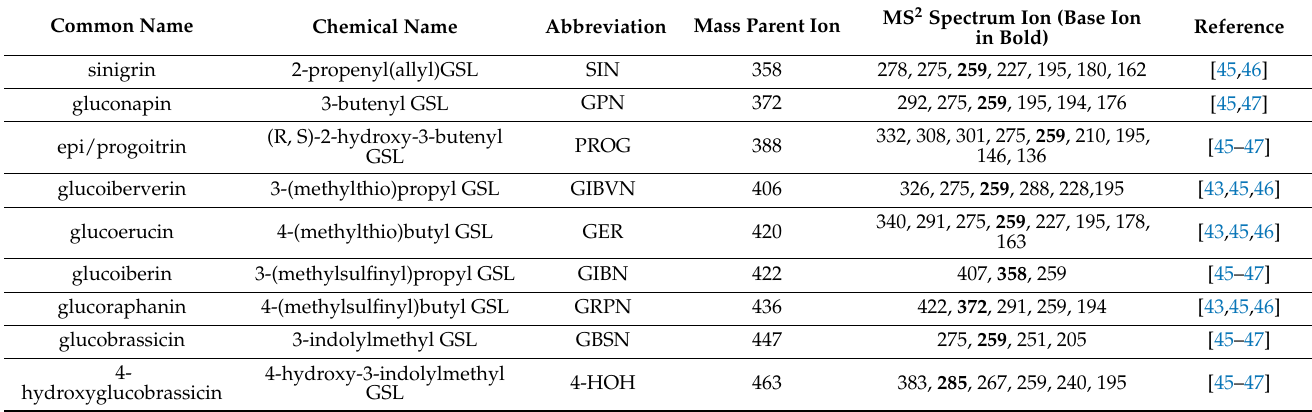
Table 1. Intact glucosinolates identified in cabbage accessions analysed by